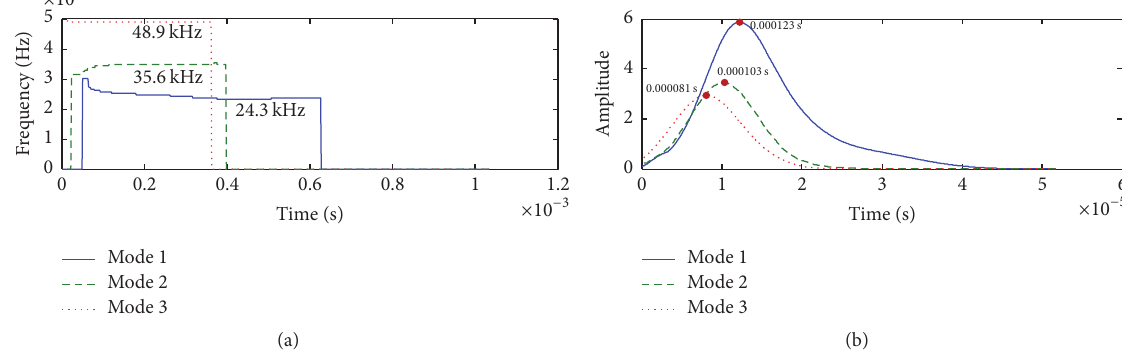
Figure 18: The final IFs and IAs of 40 mm defect by using the presented algorithm: (a) IF and (b)